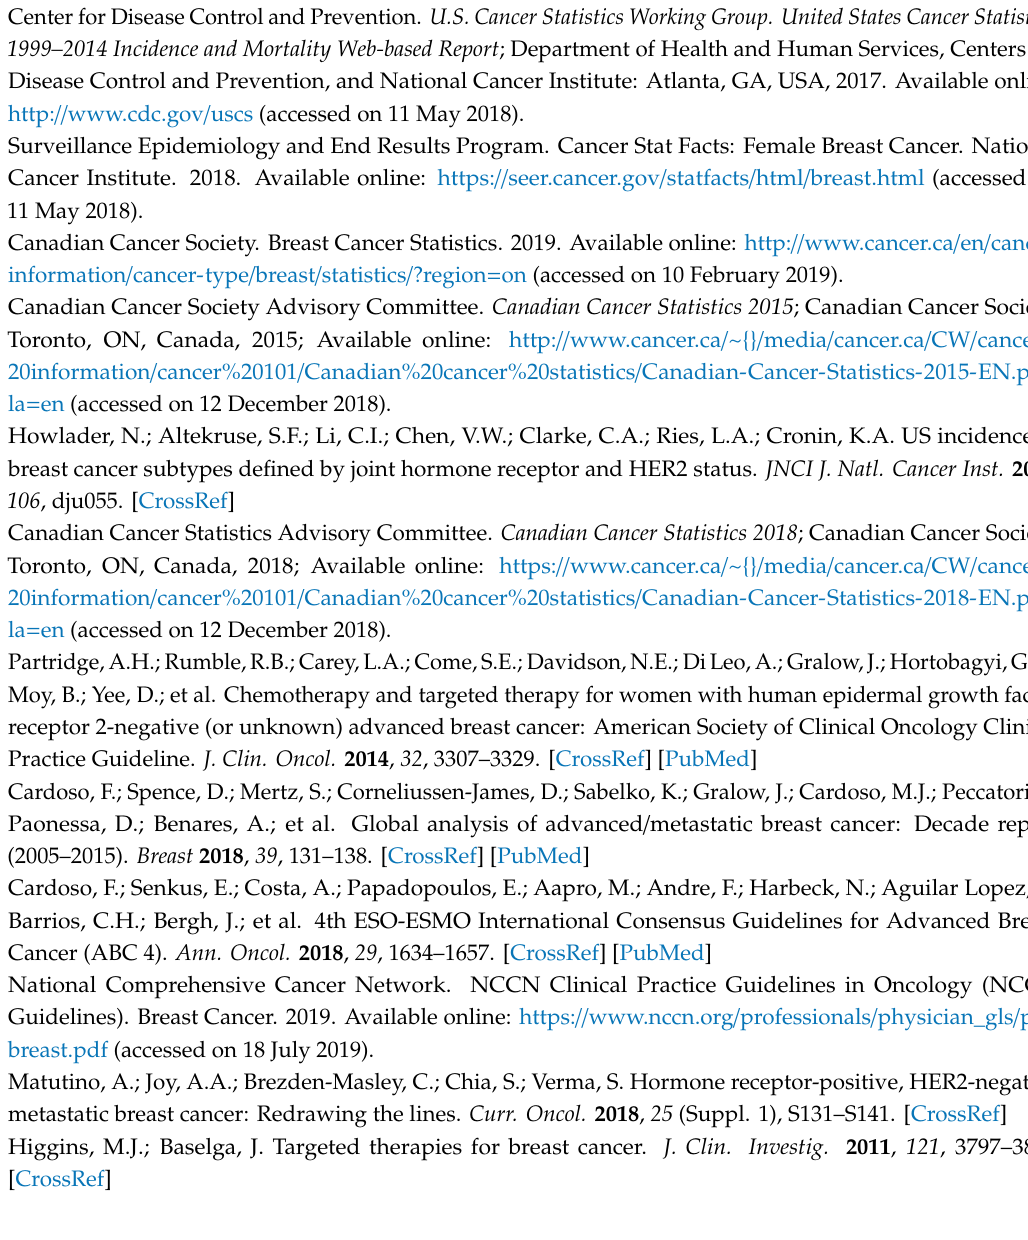
Table S1: Patients’ reported feelings of anxiety and depression; Table S2: Patients’ perceptions regarding control of their cancer; Table S3: Patients fear of cancer progression; Table S4: Patients’ perceptions regarding the e ff ects of their cancer on fertility; Supplementary Materials 1: Survey